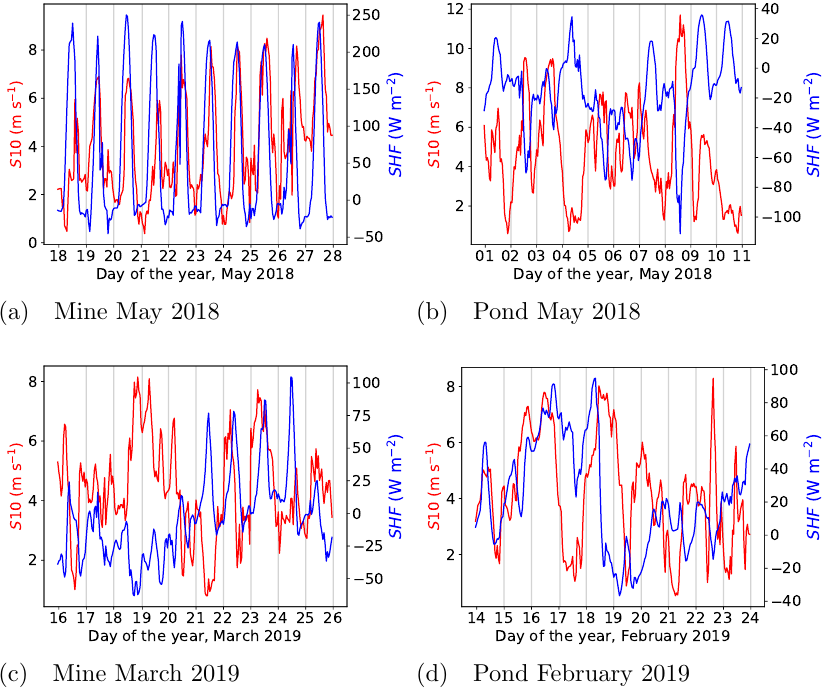
Figure A1. Time series of simulated wind speed at 10 m ( S 10) and Sensible Heat Flux ( SHF ); numbers on the horizontal axis indicate the start of day using local standard time (LST = UTC −